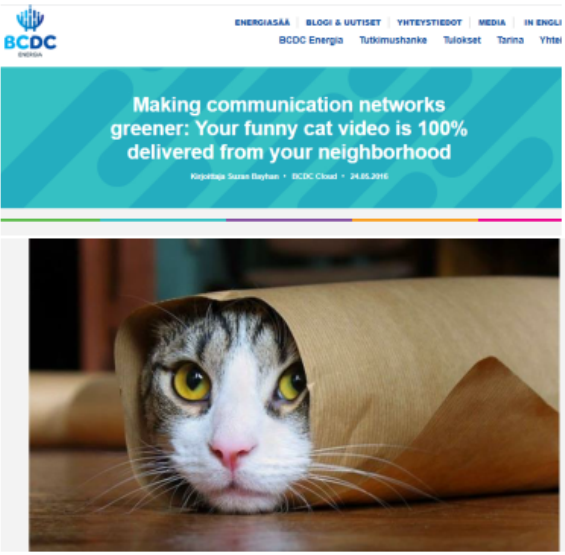
Figure 4. Maneuvering with a cat video. Source: BCDC Energy